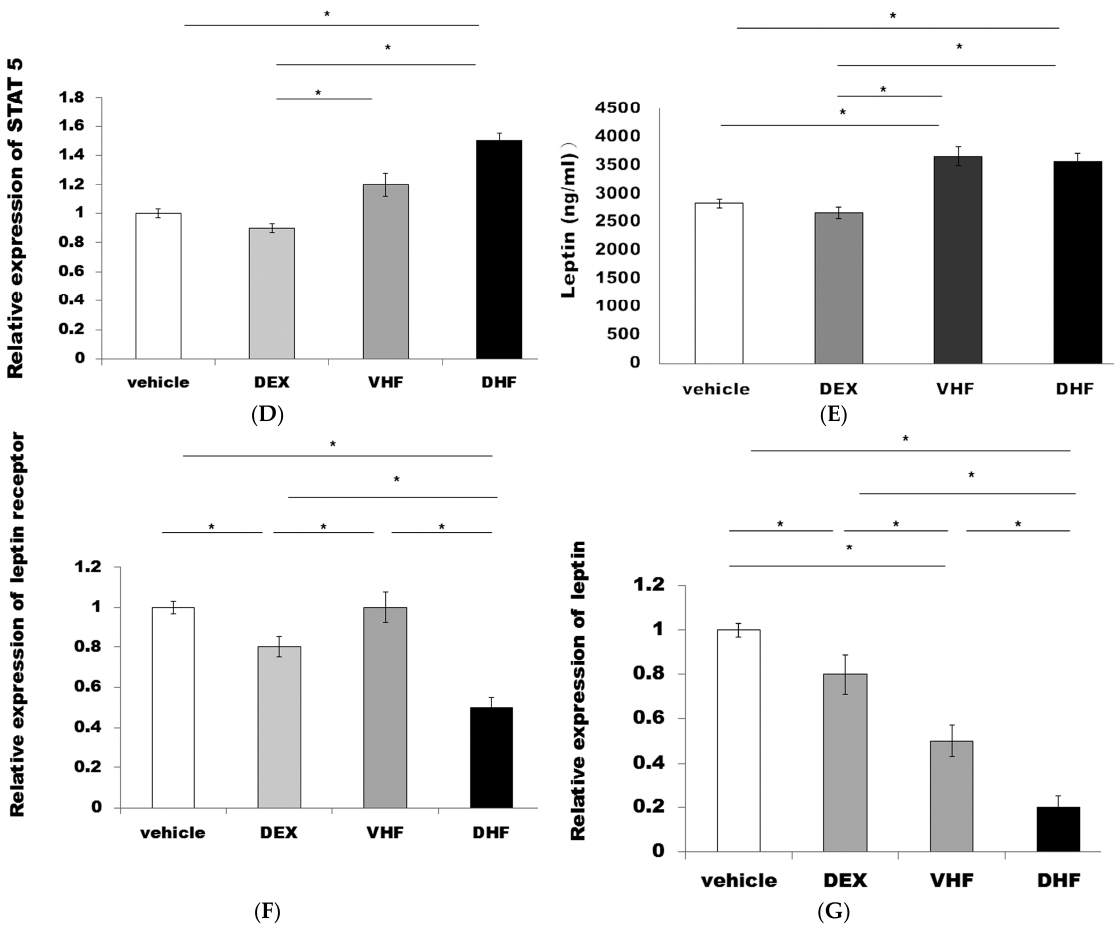
Figure 3. ( A , B , C , D ) Higher activated caspase 3, SOCS3, STAT5 expression and ( E ) serum leptin level were found in the DHF treated group and VHF treated group than in the DEX treated group and vehicle treated group. ( F , G ) Decreased liver leptin and leptin receptor expression was found in the prenatal DEX exposure plus postnatal HF diet group (DHF treated group) compared to the prenatal DEX exposure group (DEX treated group) and vehicle treated group. All the results represented mean ± standard error of six animals, * p < 0.05. The letters above each represented different groups with DEX representing the prenatal steroid treated; VHF treated group, postnatal HF diet group; DHF treated group, prenatal DEX exposure plus postnatal HF diet group.